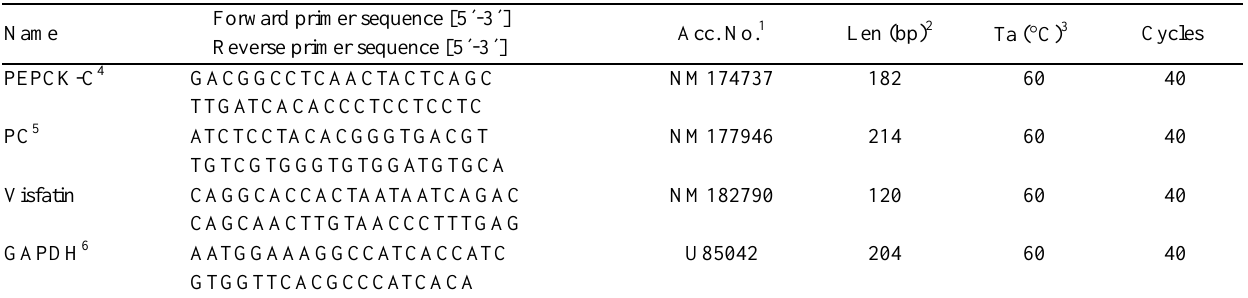
Table 2. Primer sequences and conditions used for qPCR